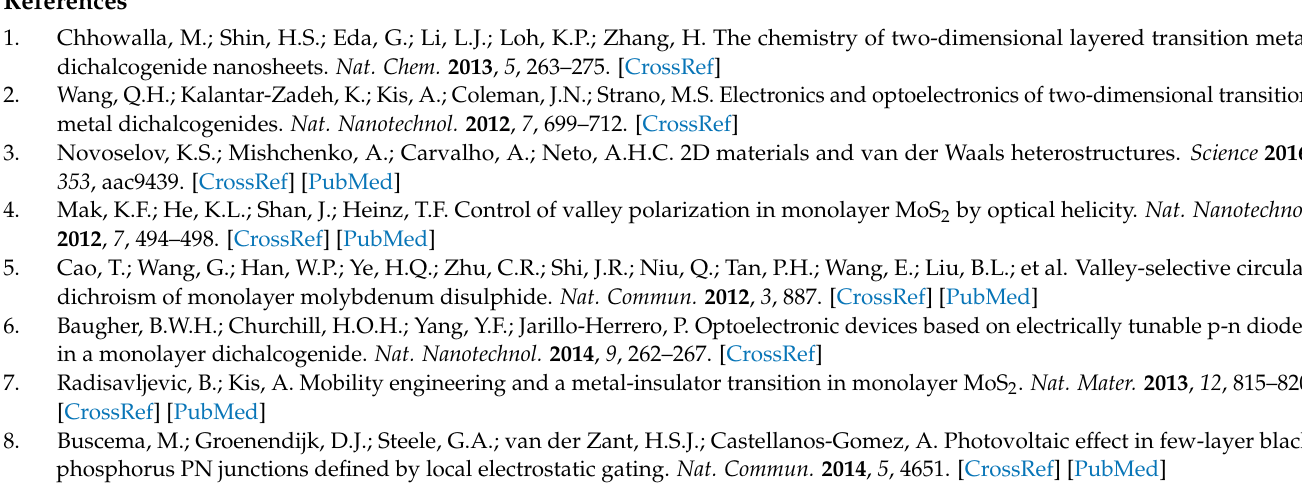
doping. Figure S4: PL spectra of monolayer MoS 2 before and after soak in DCM for 12 h. Figure S5: PL spectra of TPE-4NO 2 (a) and TPE-4OCH 3 (b) doped of immersion in dichloromethane (DCM) 12 h. Figure S6: (a–c) PL spectra of TPE, TPE-4NO 2 and TPE-4OCH 3 molecules. (d–f) Fluorescence spectra TPE, TPE-4NO 2 and TPE-4OCH 3 molecules, excitation wavelength is at 365 nm. Figure S7: Raman spectra of TPE-4NO 2 (a) and TPE-4OCH 3 (b) doped. Figure S8: The electronic band structure of (a) the monolayer MoS 2 , (b) MoS 2 /TPE-4NO 2 , (c) MoS 2 /TPE-4OCH 3